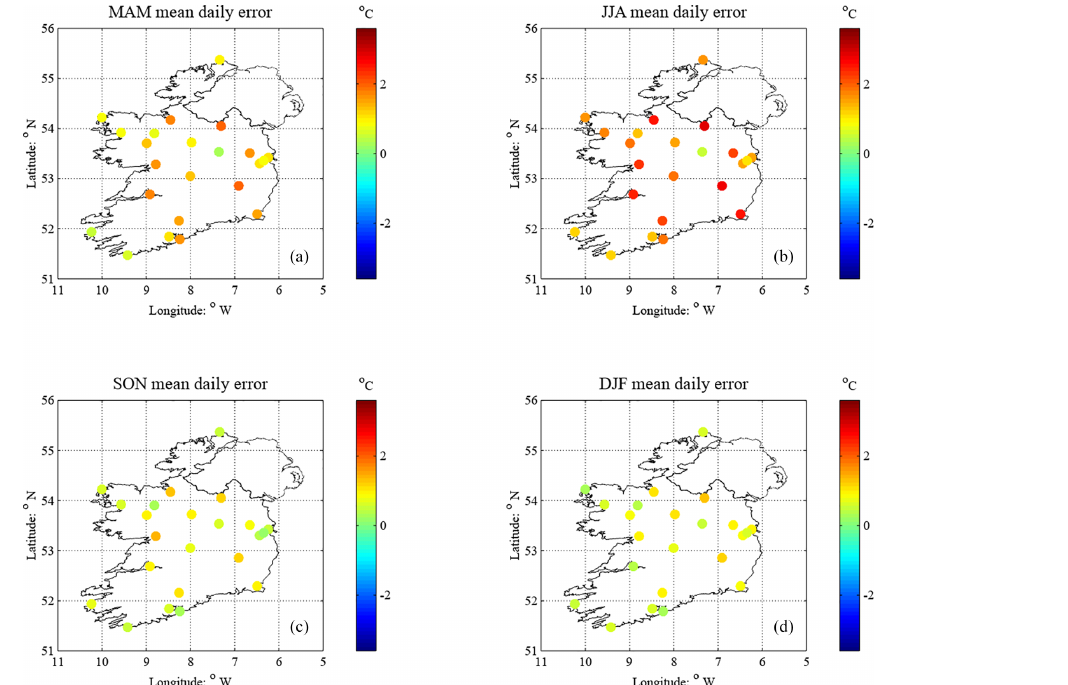
Figure 11. WRF mean daily 10cm soil temperature error per season found through comparison with observations from 23 Met Éireann station data for: (a) Spring (MAM); (b) Summer (JJA); (c) Autumn (SON); (d) Winter